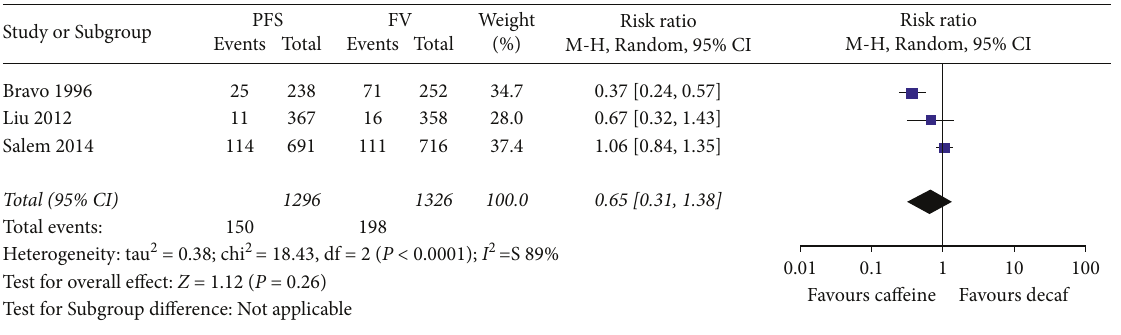
Figure 3: Meta-analysis of caries incidence of first permanent molars.